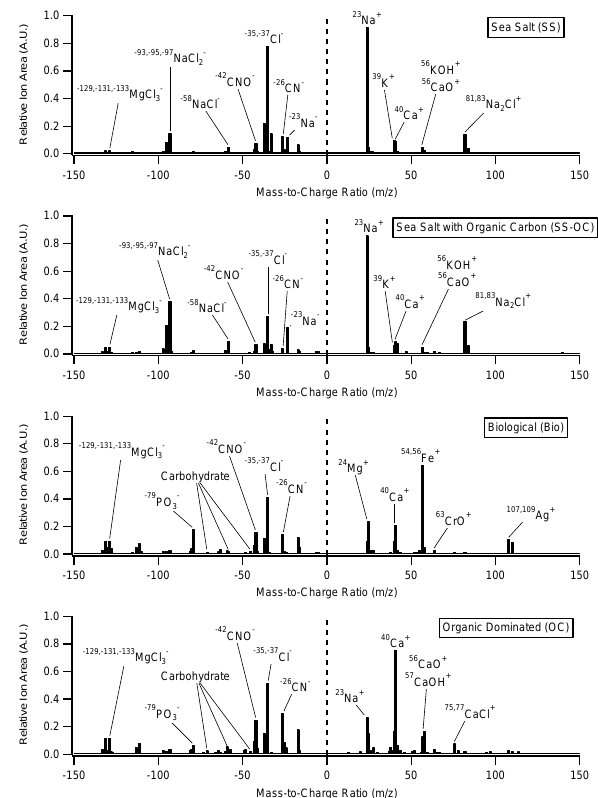
Figure 2. Representative mass spectra for each of the particle types described in this study.